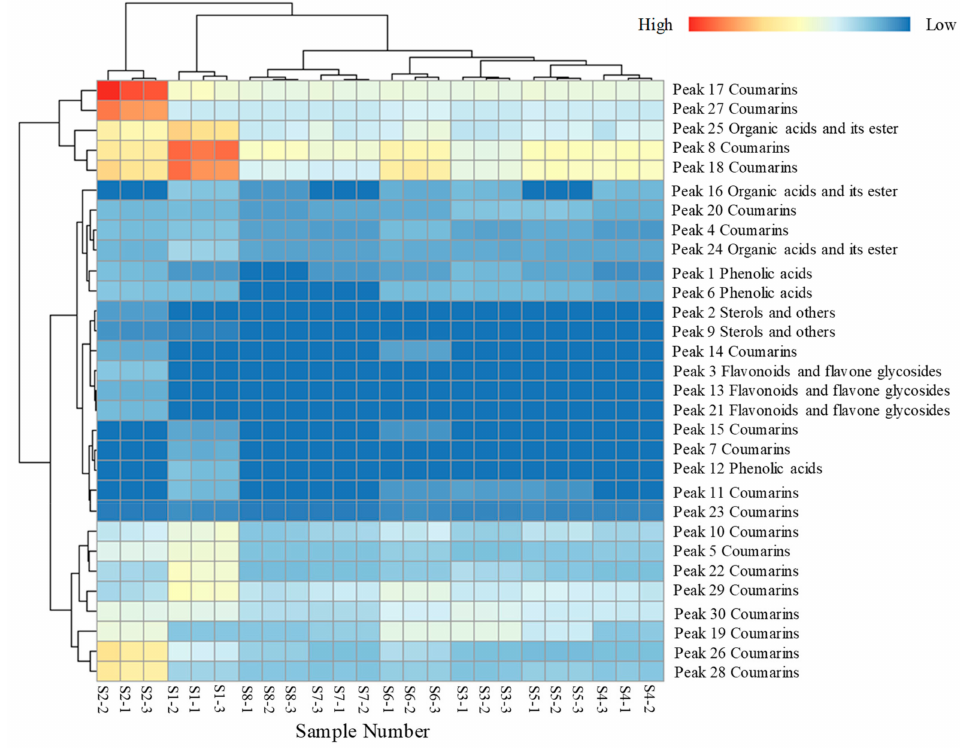
Figure 4. The heatmap analysis of annotated chemicals in fresh samples and seven processed samples by chemical